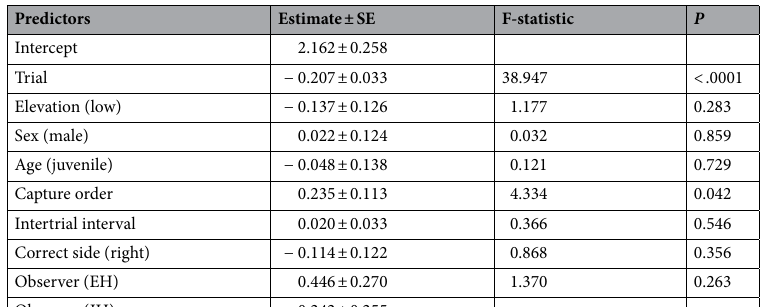
Table 1. Predictors of the log transformed number of errors made by birds (n = 62; n = 423 trials) across 7 spatial memory trials fitted with a linear mixed effect model with trial, capture order, intertrial interval (minutes), elevation (high/low), sex (male/female), age (juvenile/adult), rewarded side of the tree (left/right), and observer (EH, JH, AR) included as fixed effects. Bird ID was included as a random